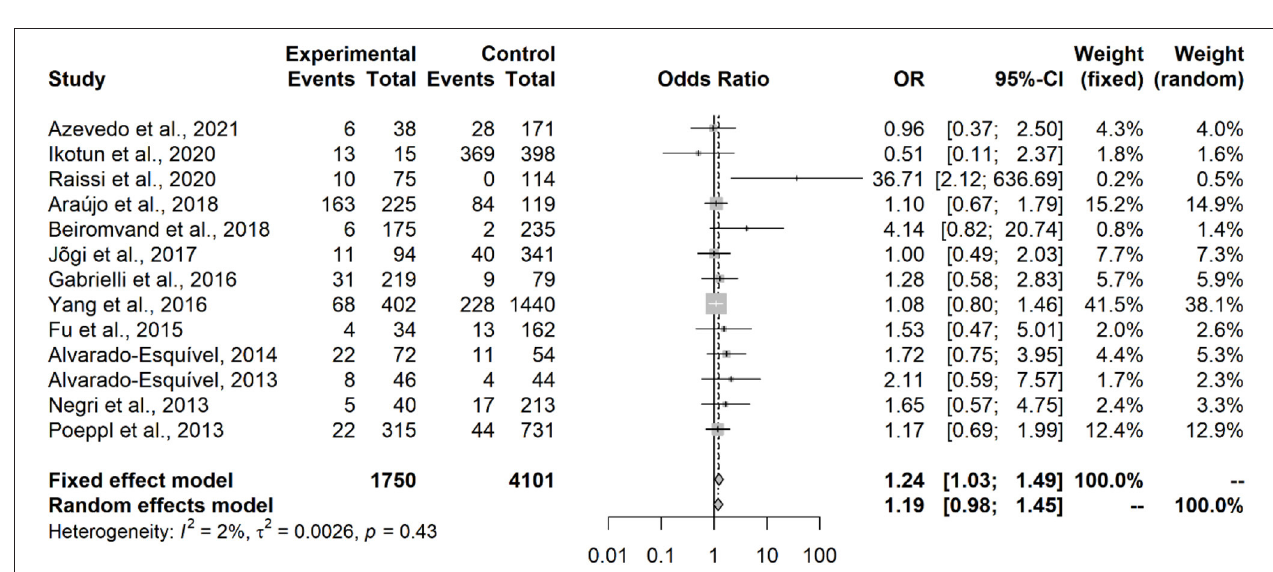
in Europe (OR = 0.79; CI 95% = 0.53–1.16) nor in Africa (OR = 2.13; CI 95% = 0.81–5.63), The single study from Southeast Asia has also no statistically significant difference (OR = 0.66; CI 95% = 0.36–1.21) concerning the presence of anti- Toxocara